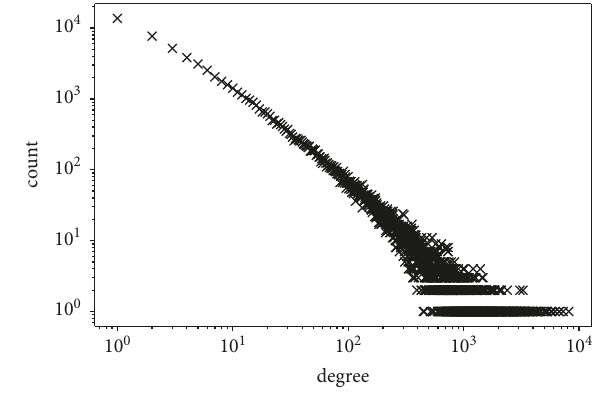
Figure 10: Degree distribution.